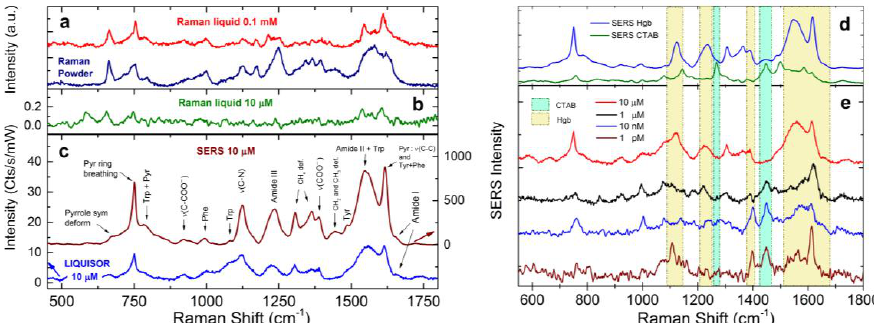
Figure 7. ( a ) Raman spectra of Hgb 0.1 mM in PB (red line—P = 18 mW, T = 60 s, two accumulations) and in powder state (blue line—P = 0.27 mW, T = 60 s, five accumulations); ( b ) Raman spectrum of Hgb 10 µM in PB (P = 18 mW, T = 240 s, two accumulations); ( c ) SERS spectra of Hgb 10 µM acquired with the LIQUISOR methodology (blue line, P = 6.5 mW, T = 1 s) and on a spontaneous aggregate formed after 24 h incubation (brown line—P = 3 mW, T = 1 s); ( d ) reference SERS spectra from aggregates for Hgb (blue line) and CTAB (green line—P = 6.5 mW, T = 1 s, 120 accumulations); and ( e ) SERS spectra of Hgb at decreasing concentrations (P = 6.5 mW, T = 1 s, 50 accumulations). Yellow boxes highlight SERS bands due to the protein while green boxes are due to the CTAB SERS peaks.